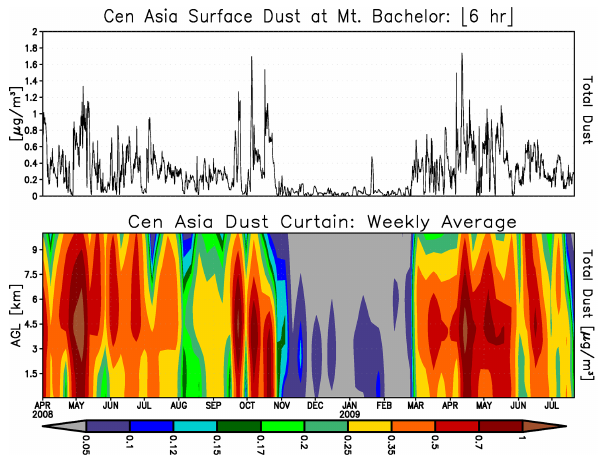
Figure 18. Time series of predicted surface concentration at 6h time step (top panel) and weekly averaged time–altitude cross sections (bottom panel) of total dust (PM 10 ) from Central Asia dust emis- sions at Mt. Bachelor, Oregon,